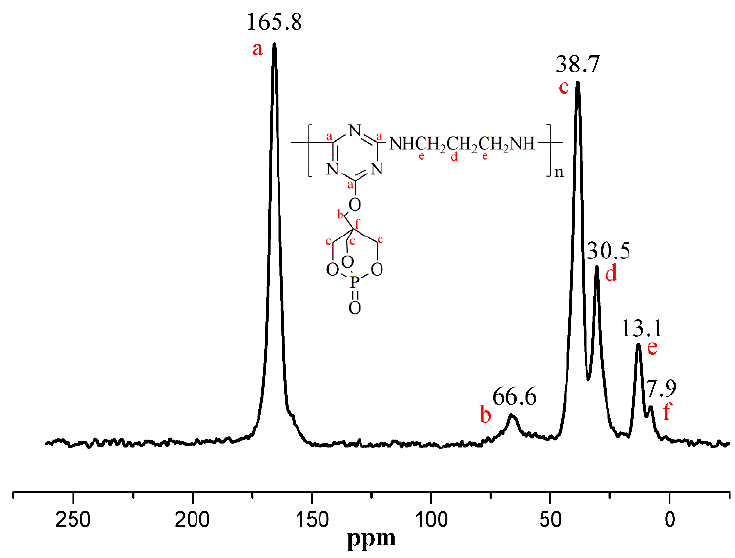
Figure 2. The 13 C solid-state nuclear magnetic resonance (NMR) spectrum of PDTBP.